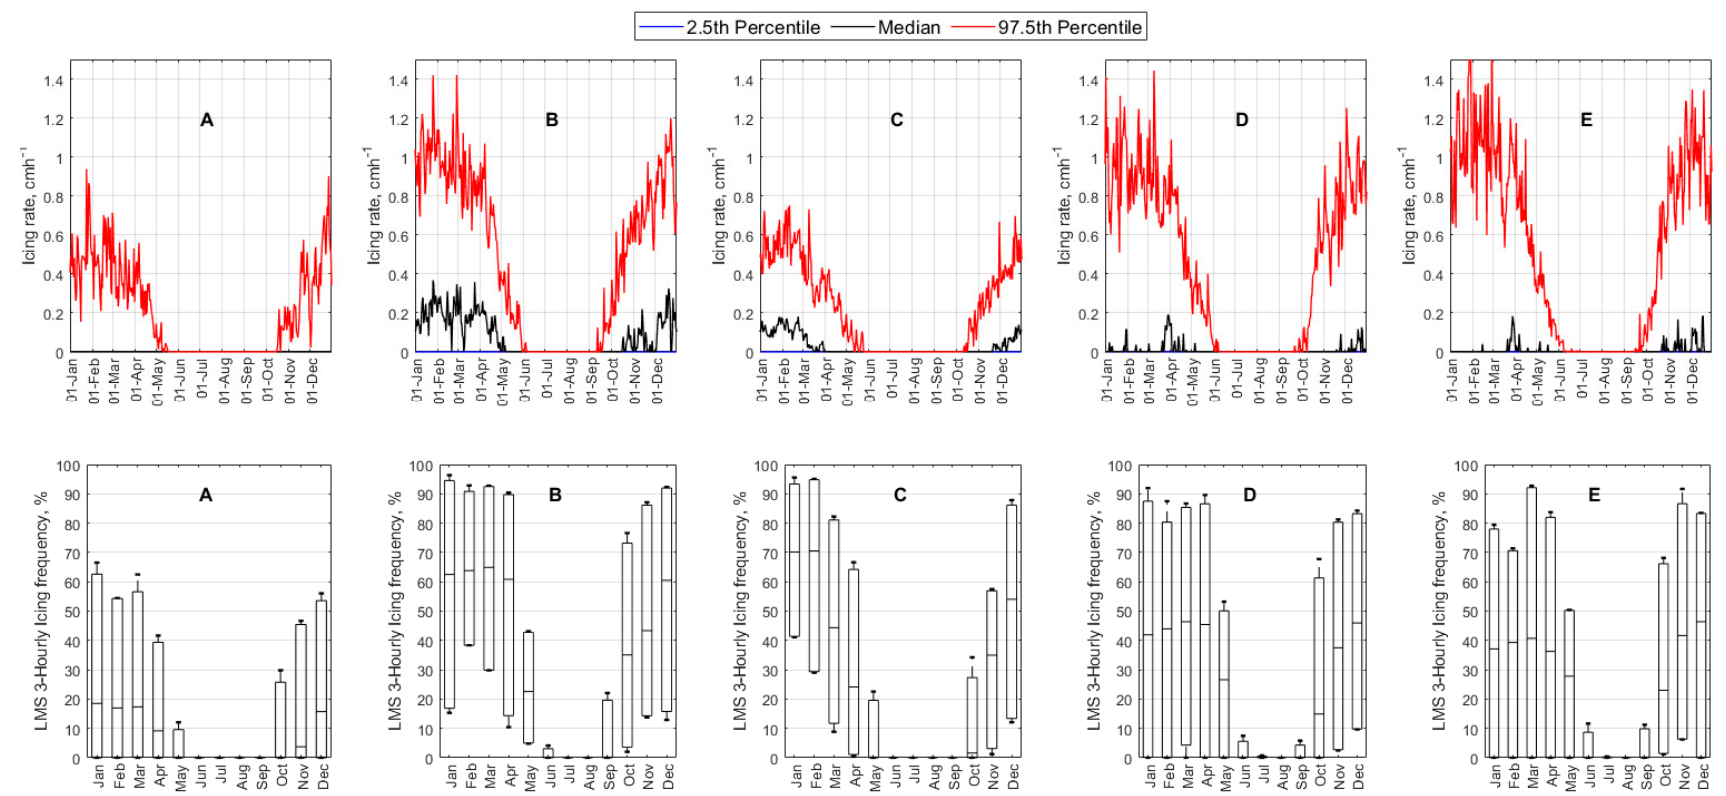
Figure 5. First row: 2.5th percentile, median, and 97.5th percentile of icing rate (all classes) for each day throughout the year. Second row: Box plot (minimum, 2.5th, 50th, and 97.5th percentiles, and maximum) of 3-hourly icing frequency (all classes) for each location in each month.